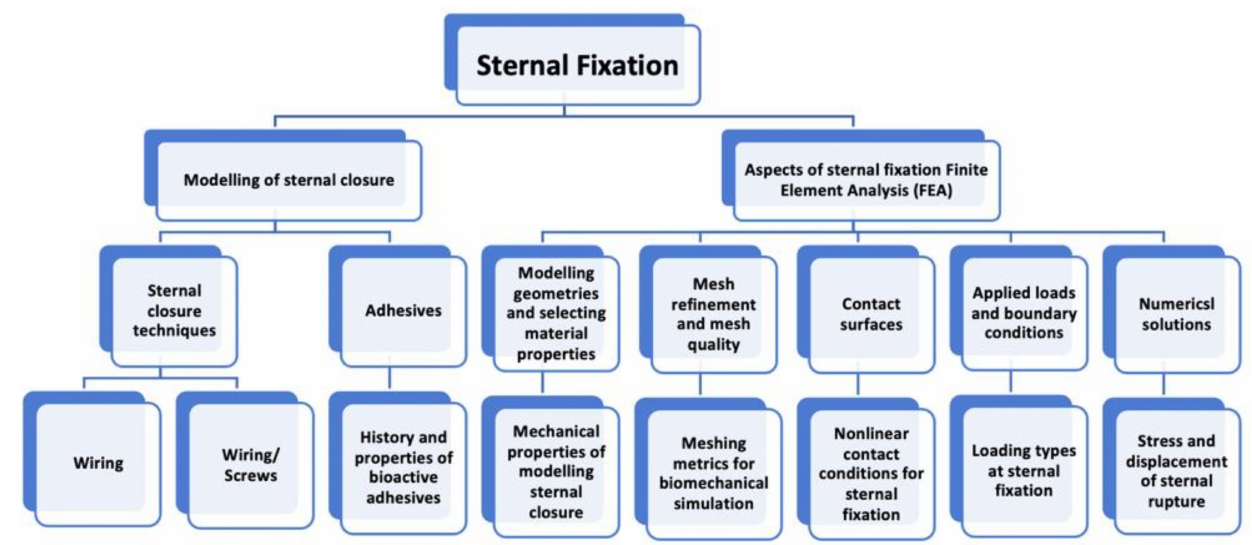
Figure 1. Topics that will be reviewed for modeling the sternal